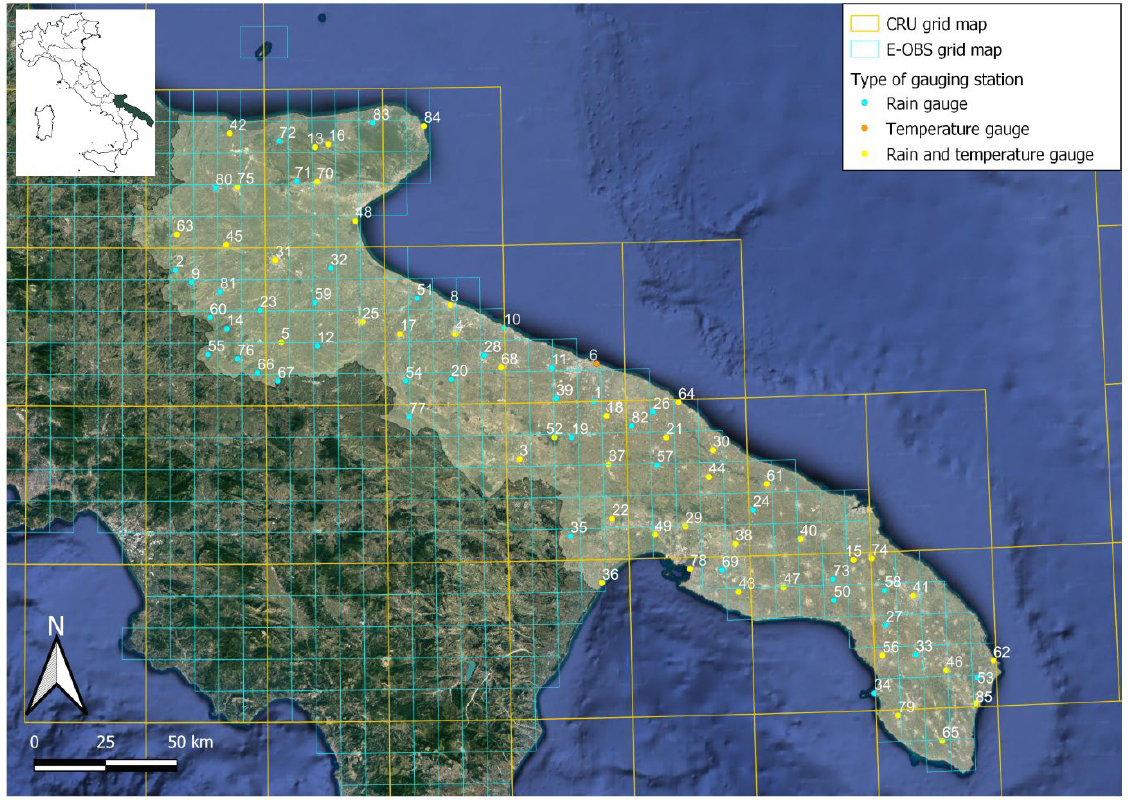
Figure 1. Overview of the study area, with indication of the considered meteorological stations (reported in Table S1) and spatial coverage of the two gridded datasets (E-OBS and CRU) selected for the analysis.